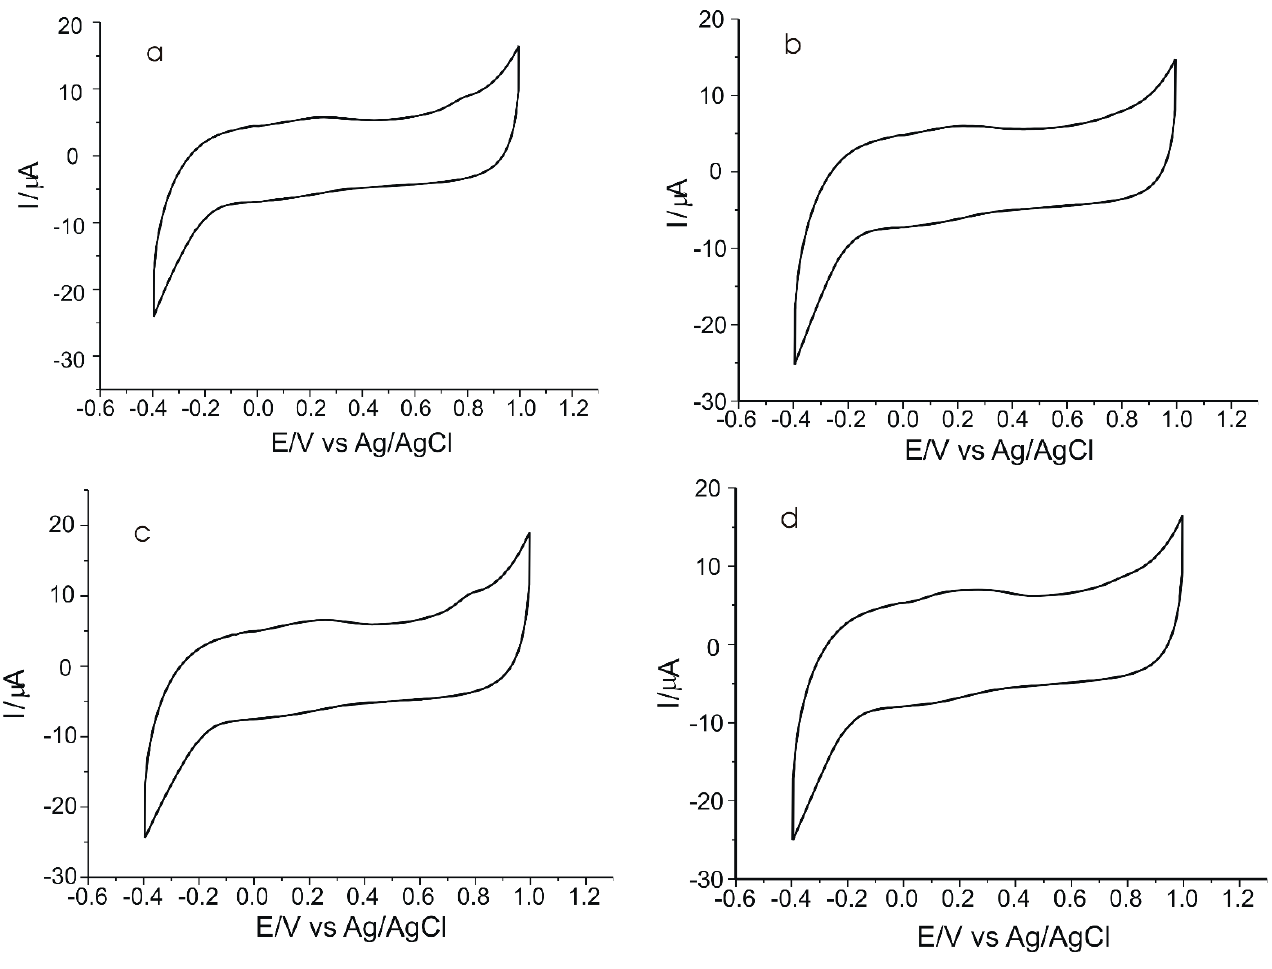
Figure 12. CVs of SPCE/GPHOX-Pentapeptide immersed in solutions obtained from the four EVOOs selected for the study: ( a ) Regina, ( b ) Mazza, ( c ) Minerva, ( d ) Costa D’Oro L’extra.